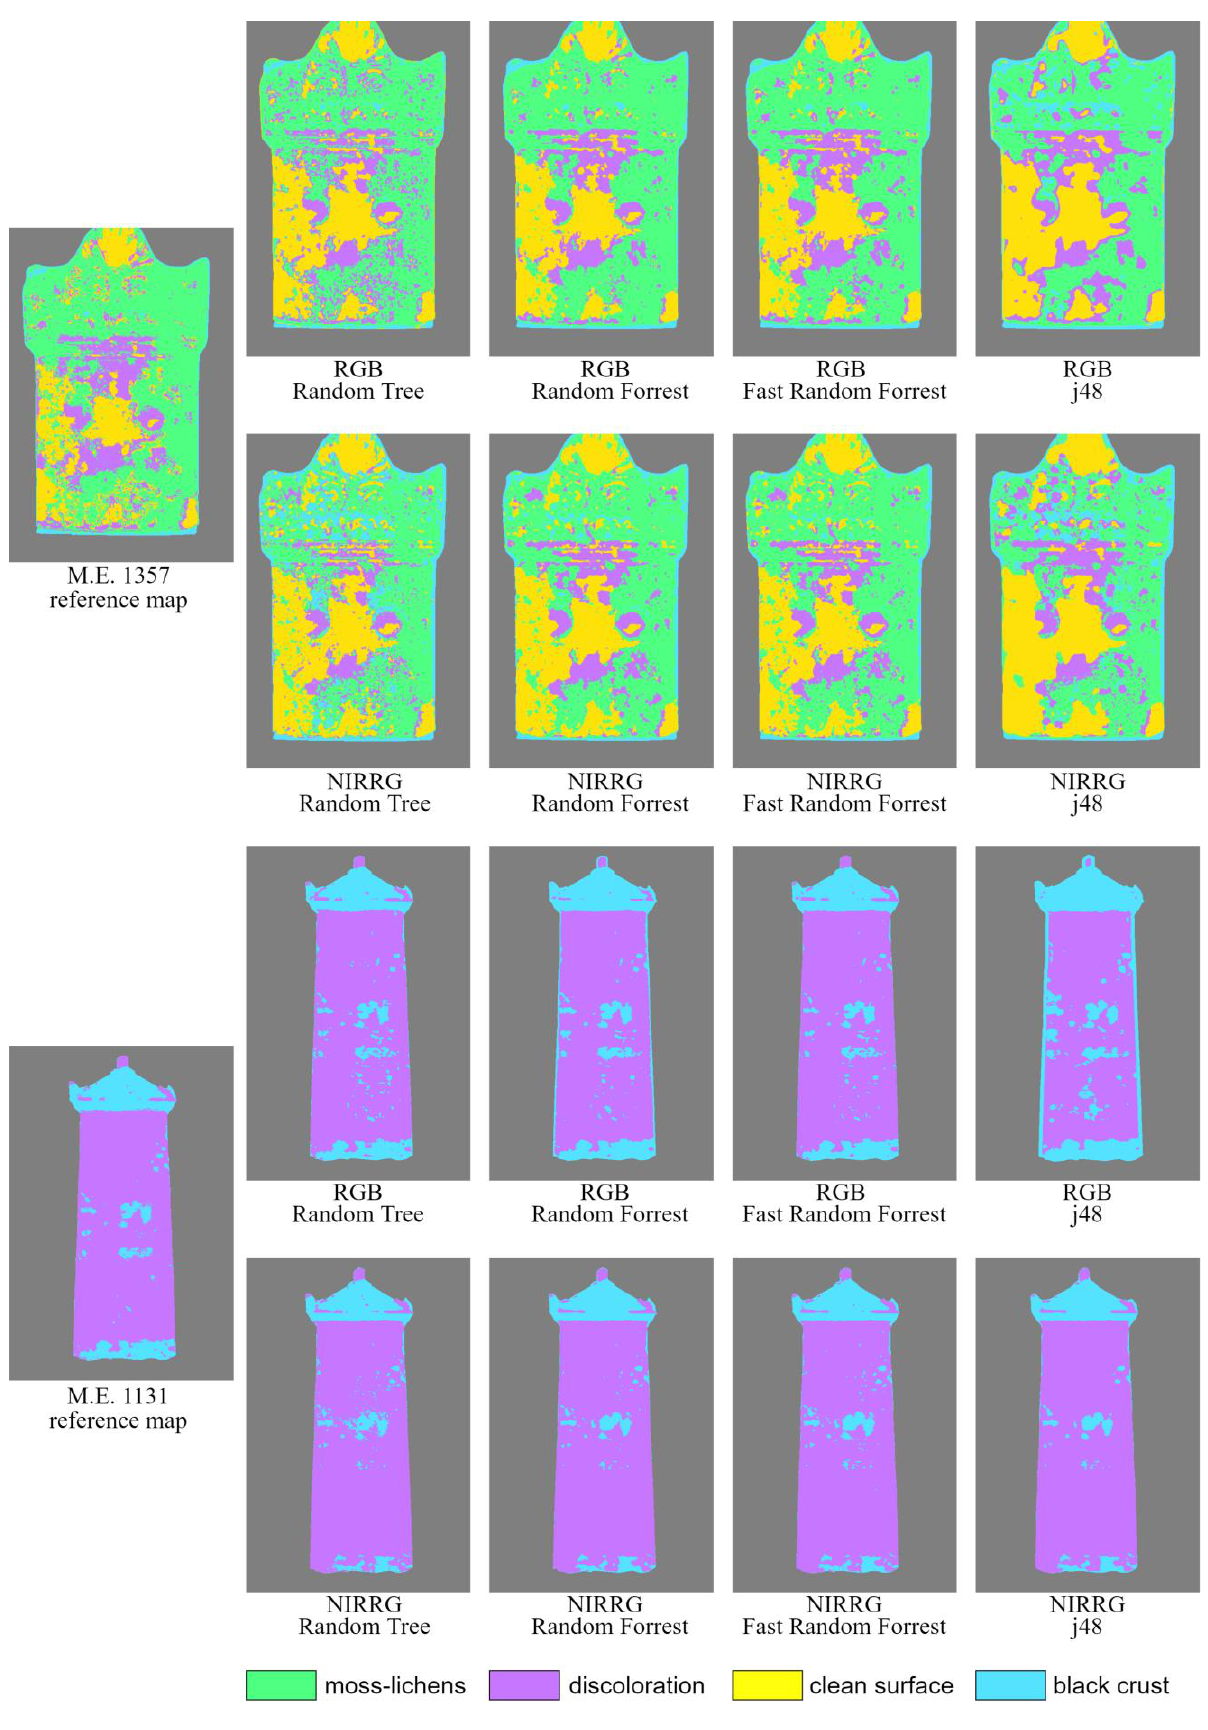
Figure 4. Classification results stelae M.E. 1357 and M.E.